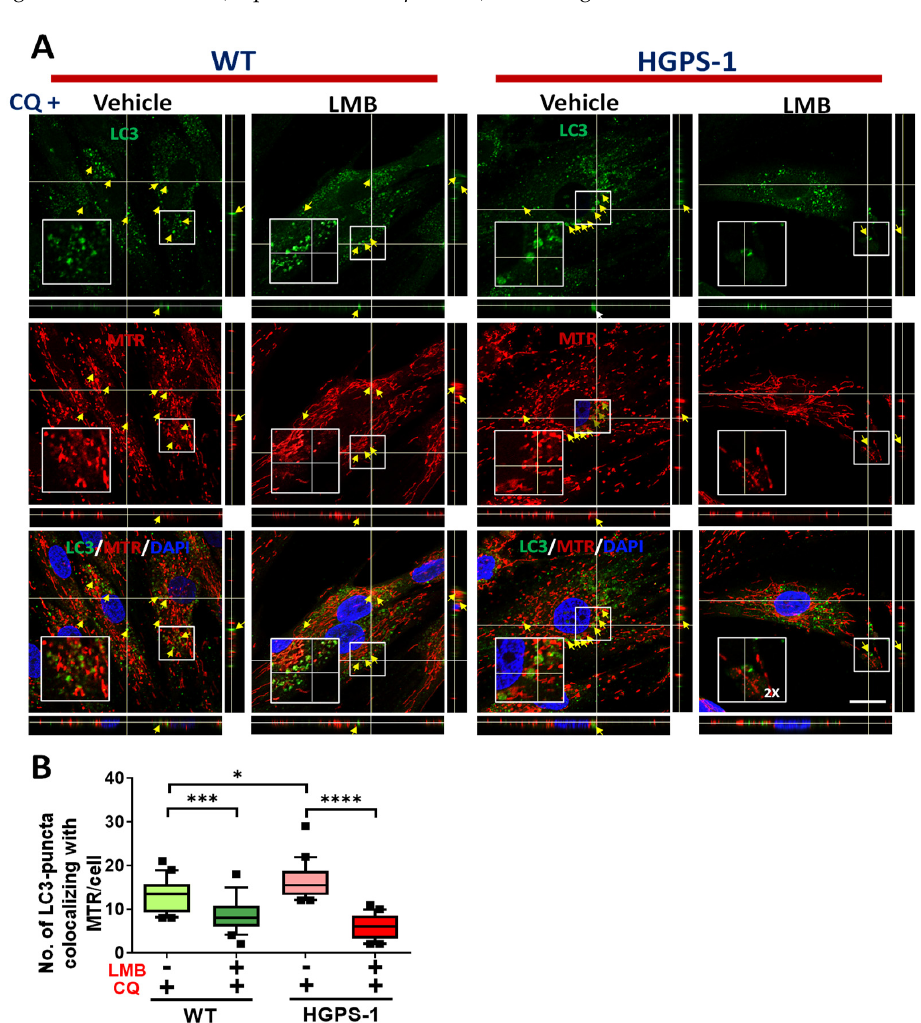
Figure 6. Increased colocalization of LC3 puncta and mitochondria in HGPS-1 cells is normalized in the presence of LMB with an autophagy inhibitor. ( A ) WT and HGPS-1 cells grown on coverslips